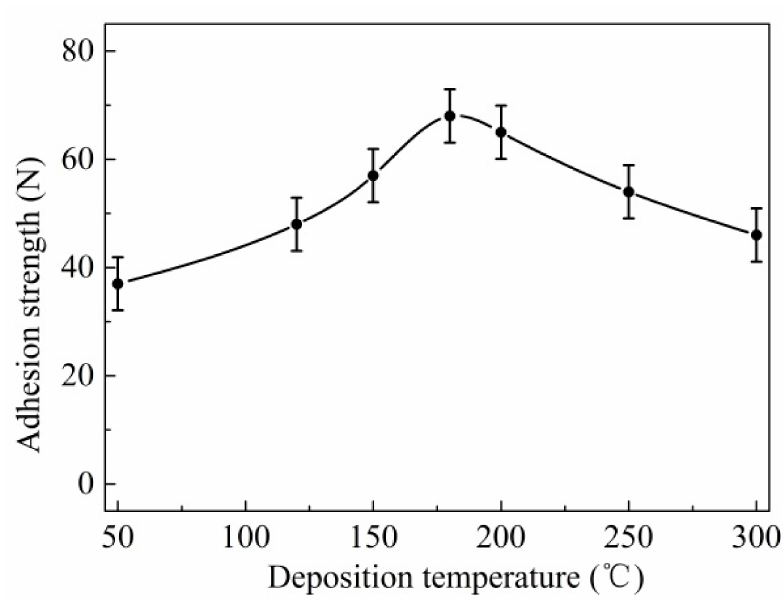
Figure 6. Adhesive strength of coated samples at various deposition temperatures.